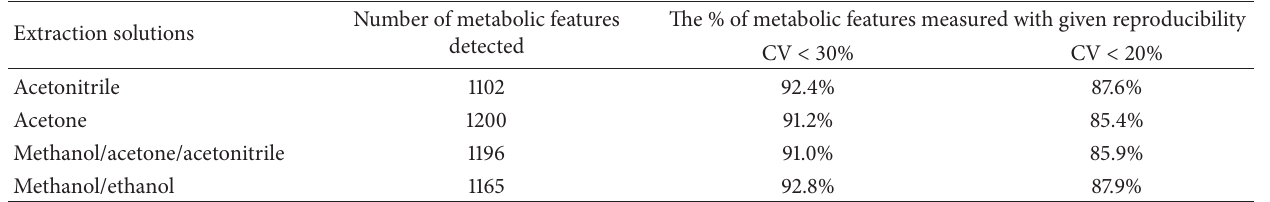
Table 1: The number of metabolic features detected in different aqueous humor extracts.